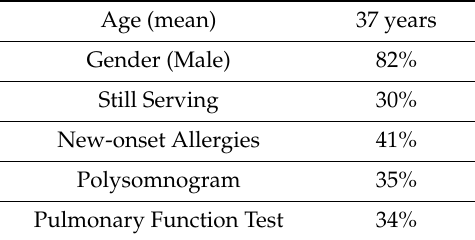
Table 1. Demographic characteristics of participants at the time